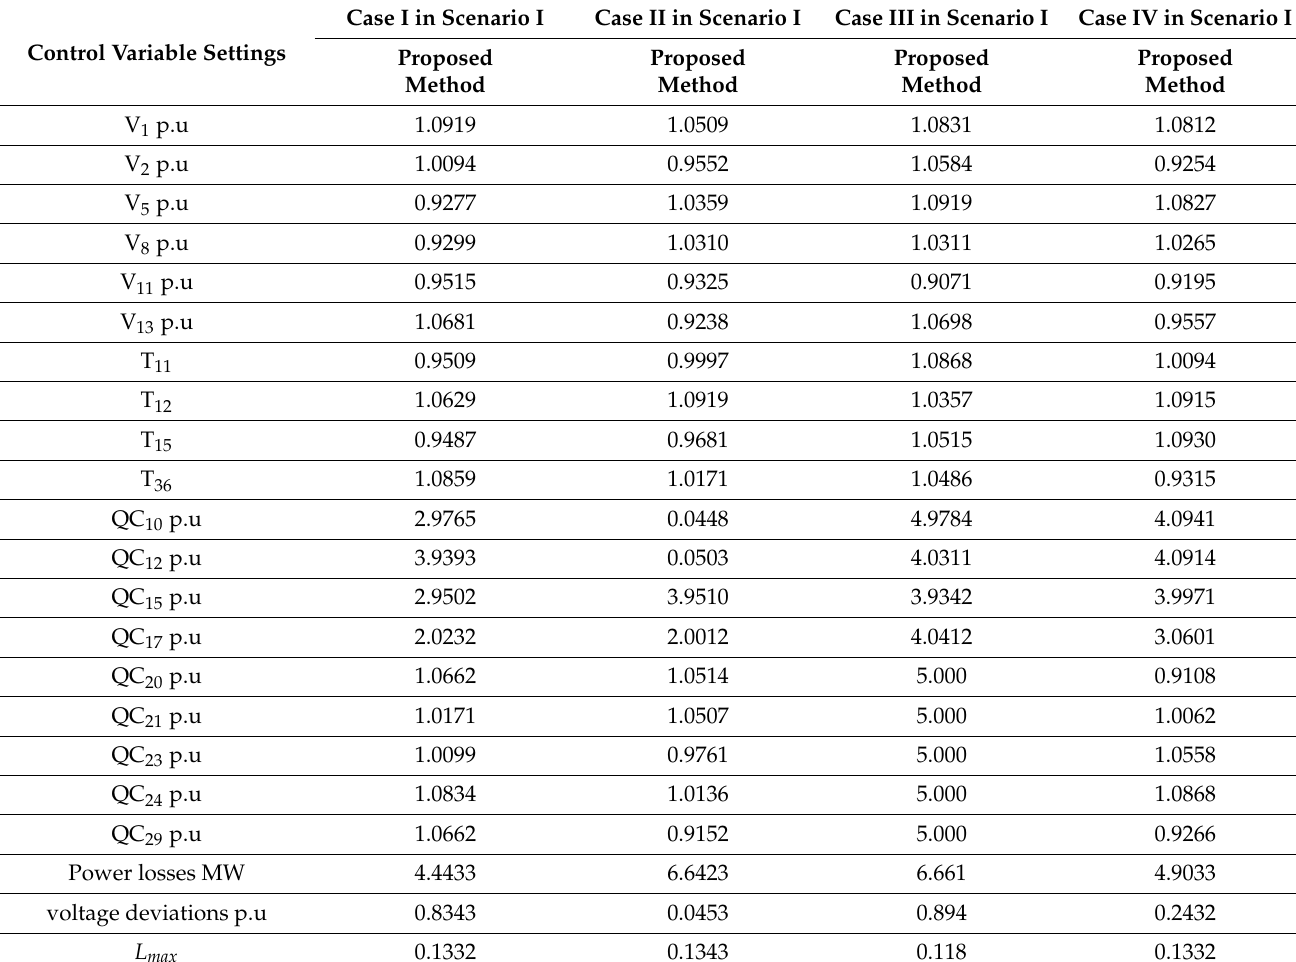
Table 1. Output Control Variables Obtained After Optimization For IEEE 30